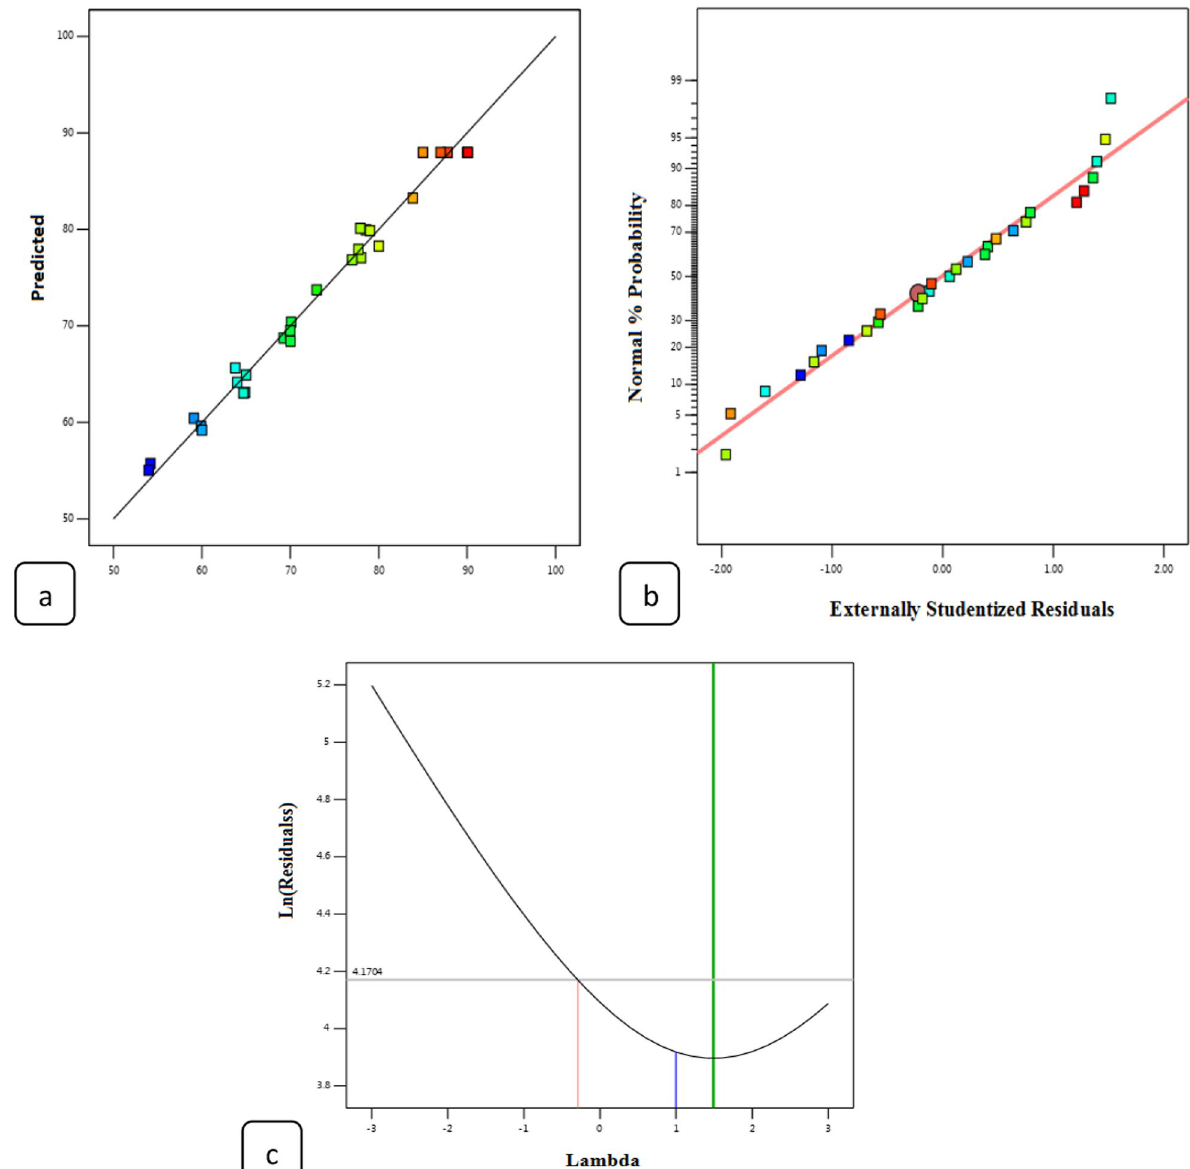
Fig. 20 a Actual and predicted values for the decolourization of MG dye by immobilized Mucor sp., b normal % probability and c Box–Cox